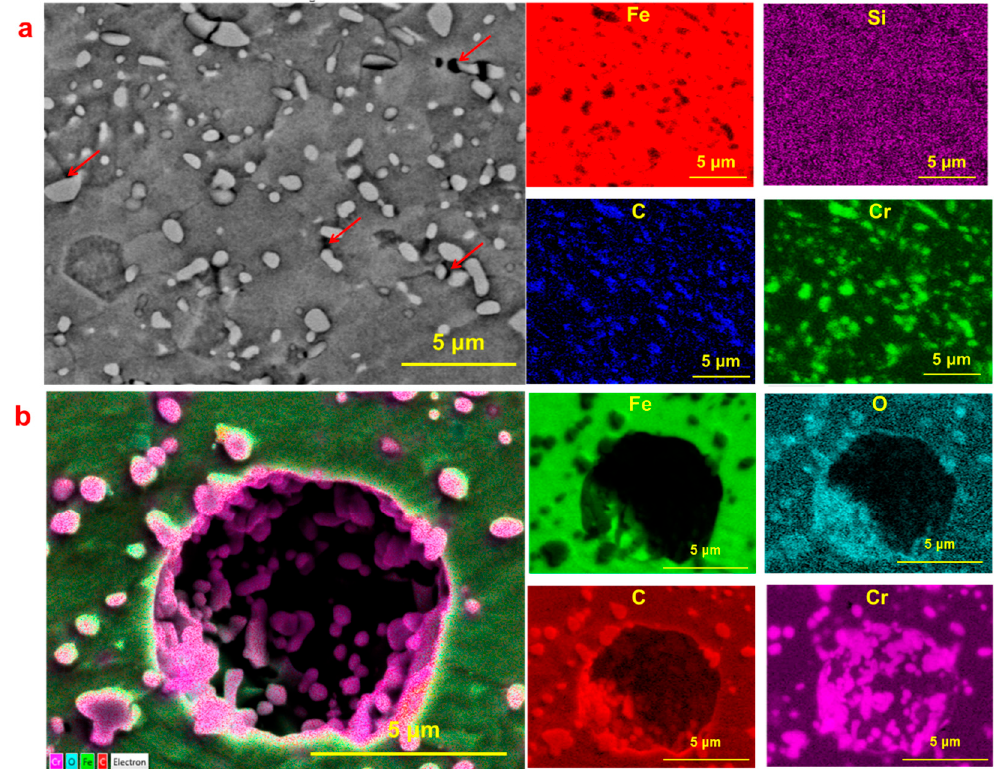
Figure 5. ( a ) SEM images with EDX maps of Type 420 stainless steel after 5 s exposure time, with the arrow highlighting a pit nucleation site, and ( b ) EDX maps of a pitting with 5 um diameter with corresponding EDX maps. Metals 2020 , 10 , 794 8 of 17